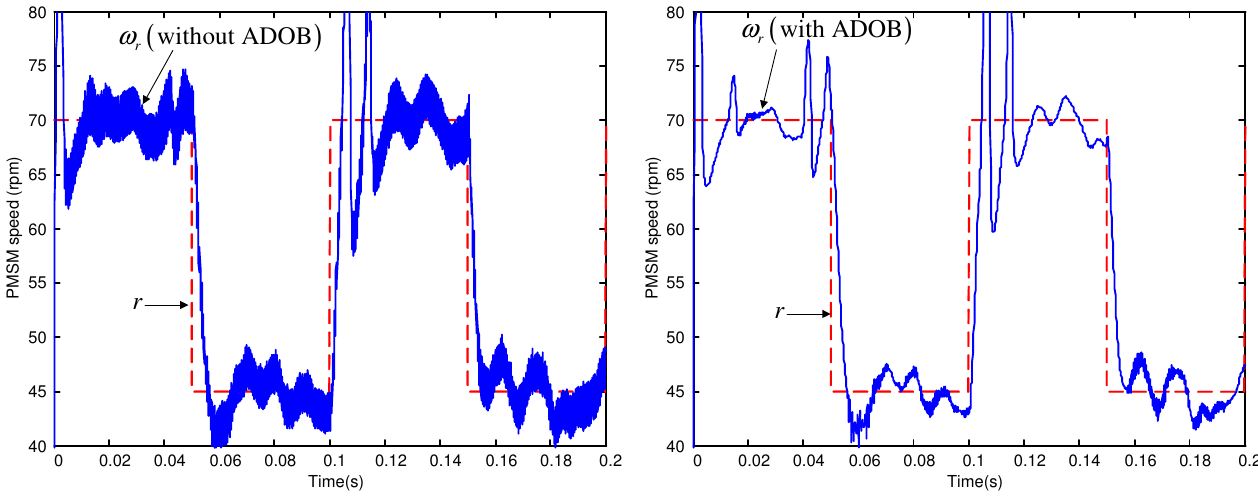
Figure 10. ( Left ) PMSM speed response without ADOB; ( Right ) PMSM speed response with ADOB.